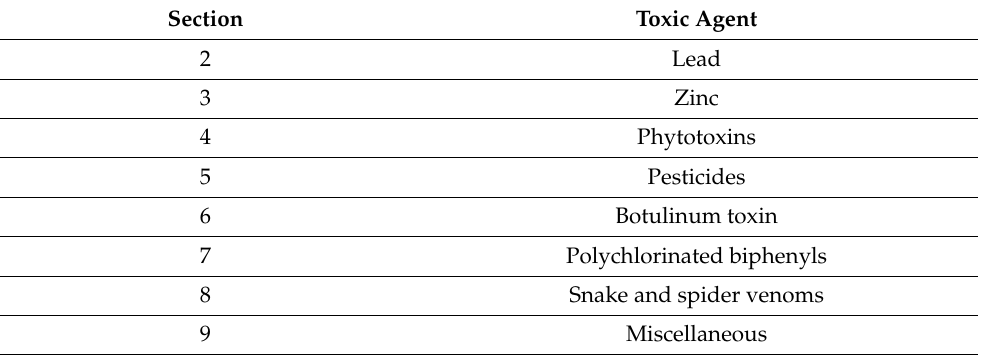
Table 1. The main toxic agents in nonhuman primates.